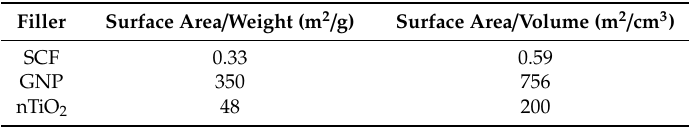
Table 3. The surface area of the three fillers: short carbon fiber (SCF) micro-size, graphite nano-platelet (GNP), and Titanium dioxide nanoparticles (nTiO 2 ).